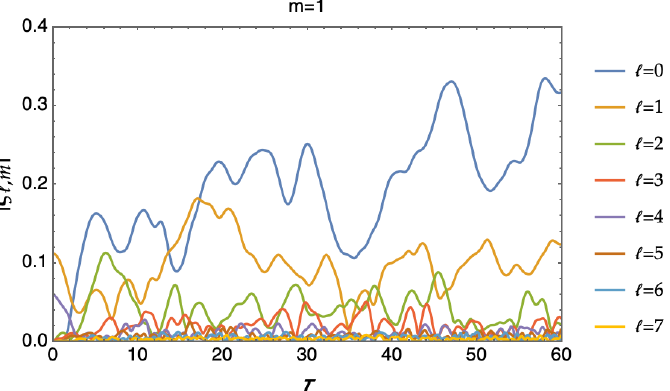
Figure 4. Case A1—inviscid. Early temporal evolution of | ξ (cid:96) ,1 | with (cid:96) (cid:62) 0. The final time is chosen to highlight the mode saturation mechanism.